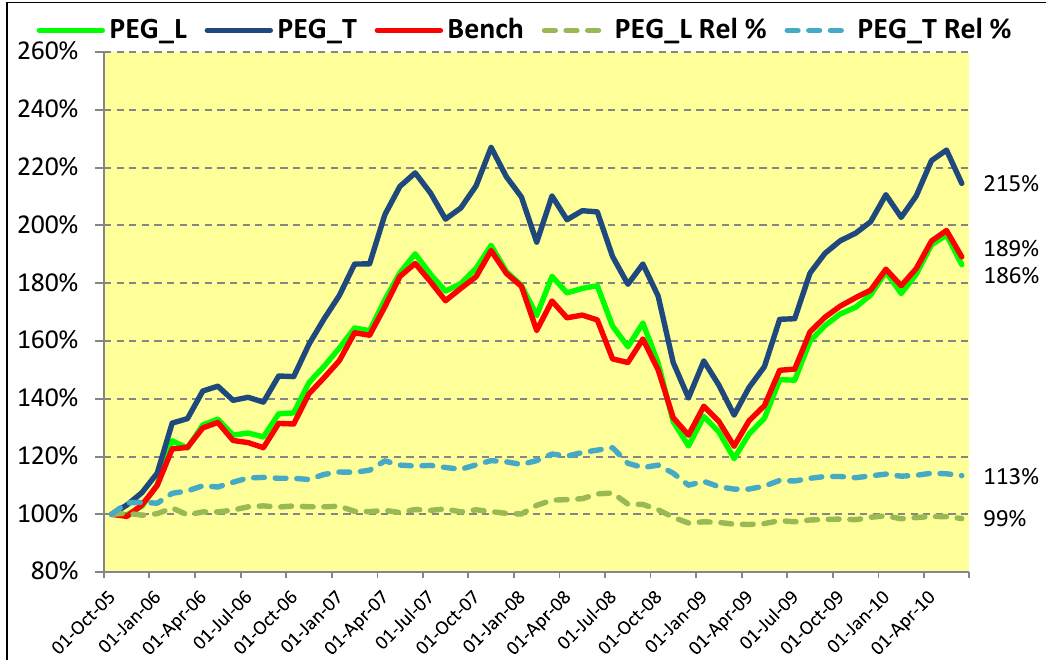
Figure2: Comparison of ‘normal’ PEG trading rule